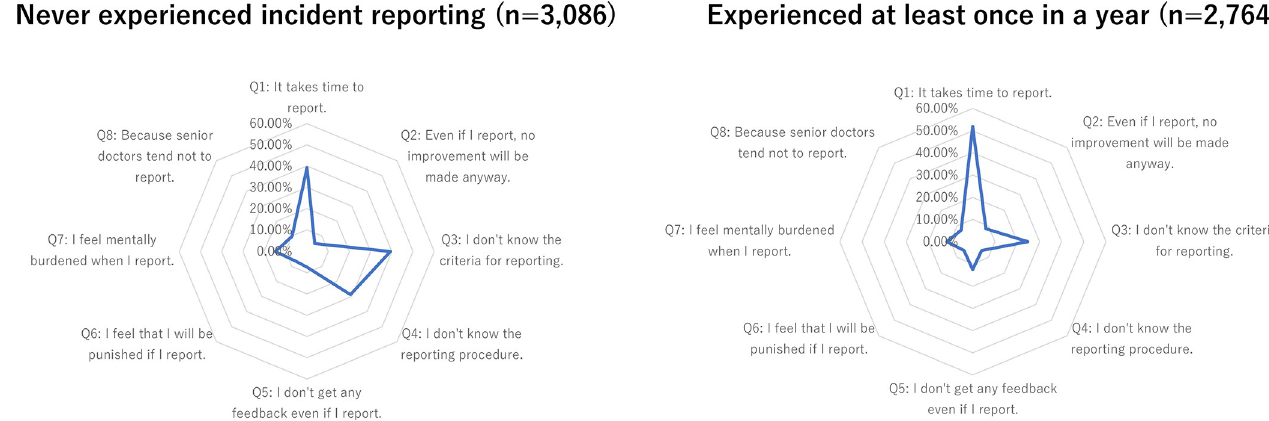
Fig 2. Radar chart of barriers to incident reporting. Left: Participants who never experienced incident reporting. Right: Participants who experienced incident reporting at least once a year.